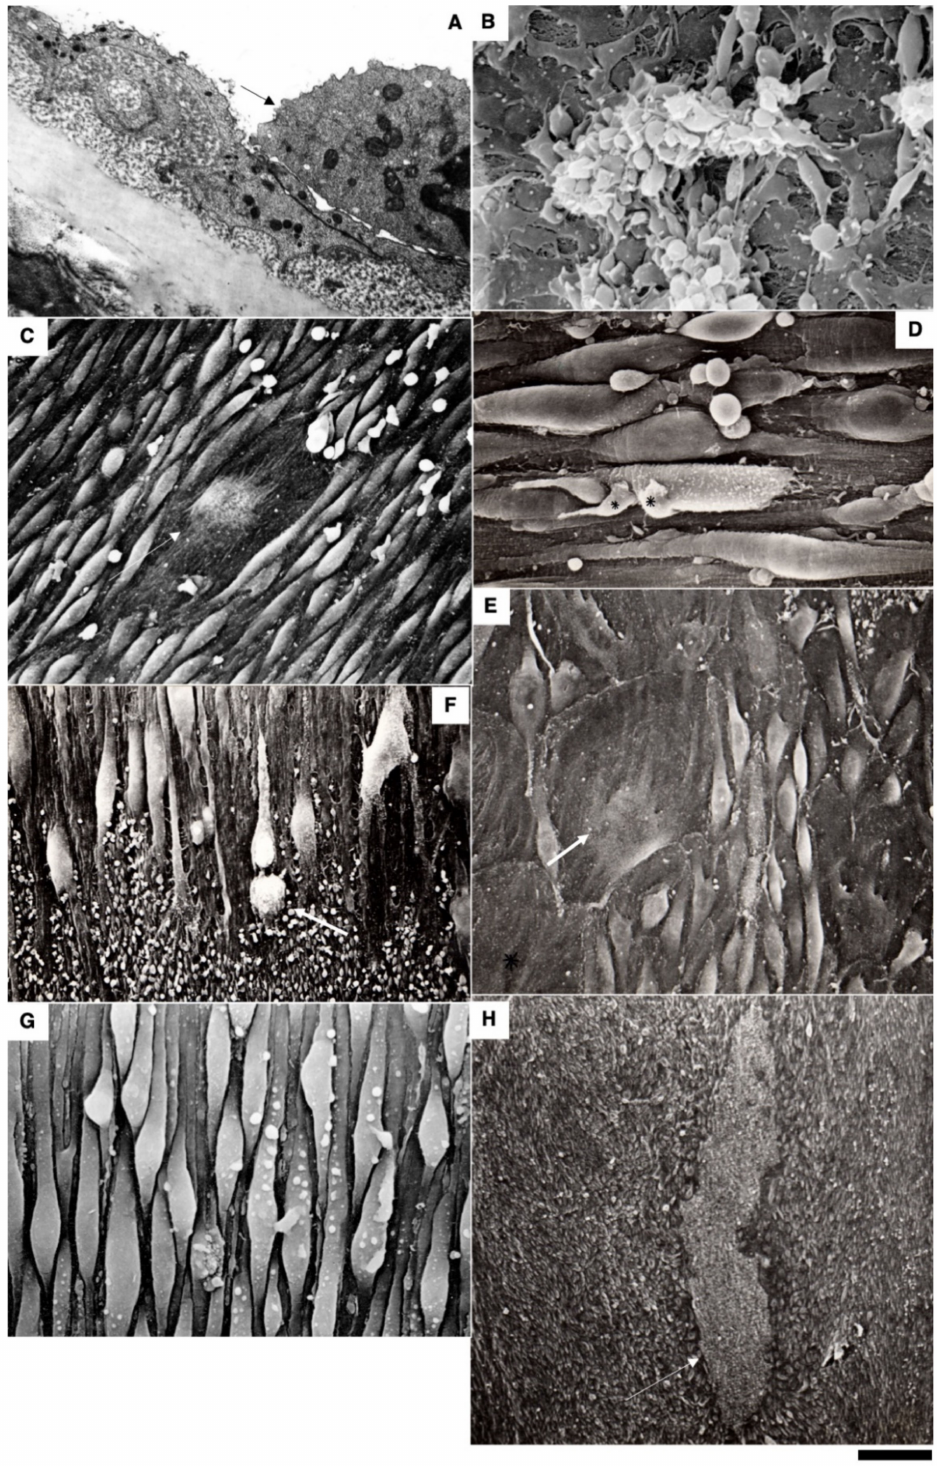
Figure 7. Features of ECs in re-endotheliazation zone after single ( G ) and multiple cryoinjuries ( A , D , H ), as well as after single injuries in old ( C , F ) and hypertensive rats ( B , E ). ( A ) TEM. ( B – H ) SEM. ( A ) Monocyte (arrow) is attached to EC of the re-endothelialized zone. ( B ) Aggregate of platelets. ( C , E ) Giant ECs in old © and hypertensive ( C ) rats. ( F ) Ugly ECs in the leading edge. Asymmetric mitosis (arrow). ( H ). Area not yet covered with ECs. ( H ) Altered shape of de-endothelialization zone after multiple re-endothelialization. Scale bars: 2 µ m ( A ); 3 µ m ( B ); 8 µ m ( C ); 4 µ m ( D , G ); 6.5 µ m ( E ); 7 µ m ( E ); 90 µ m ( H